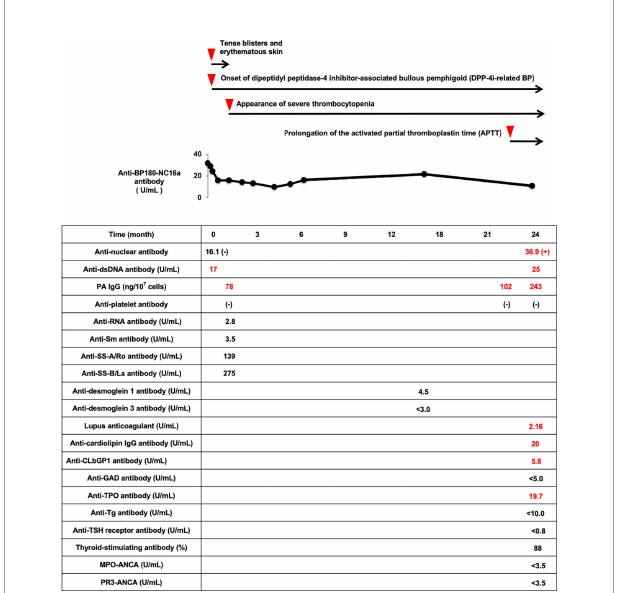
FIGURE 2 | Timecourseofthe appearanceofvariousdisease-speci fi cantibodies after theonsetofDPP-4i-relatedBPinthissubject.After the onsetofDPP-4i-related BP, variousdisease-speci fi cantibodies arecontinuouslyproducedandtheir titers areelevated. DPP-4i-relatedBP,dipeptidylpeptidase-4inhibitor-associatedbullous pemphigoid; APTT, activated partial thromboplastin time; ANA, anti-nuclear antibody; dsDNA, double stranded DNA IgG; PAIgG, platelet-associated IgG; RNP, ribonucleoprotein; GAD, glutamic acid decarboxylase; CL b 2GP1, cardiolipin b 2-glycoprotein I; TPO, thyroid peroxidase; Tg, thyroglobulin; MPO-ANCA, myeloperoxidase-anti-neutrophil cytoplasmic antibody; PR3- ANCA, neutrophil cytoplasmic